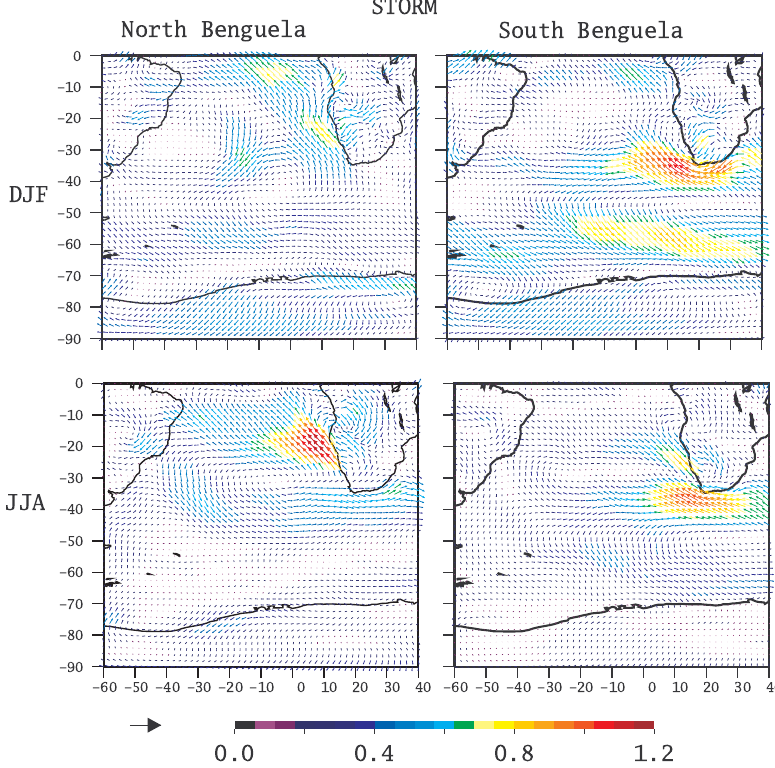
Figure 9. Correlation patterns between the simulated upwelling indices and the NCEP/NCAR wind stress for North and South Benguela and for DJF and JJA in the period 1950–2010. The zonal and meridional components of the arrows represent the correlation with the corresponding component of the wind stress. The colours code the square root of the sum of these zonal and meridional correlations